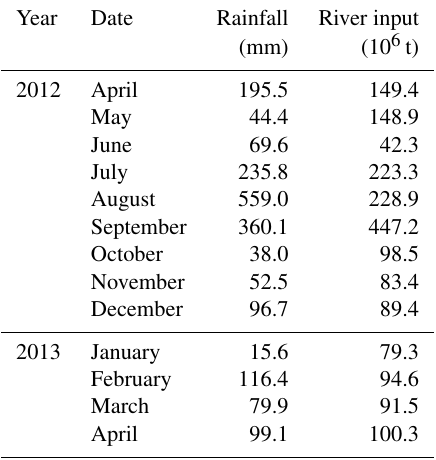
Table 3. The monthly patterns of rainfall and river input. Table 4. The δ 13 C values and C:N ratios of POM at the surface in Gwangyang